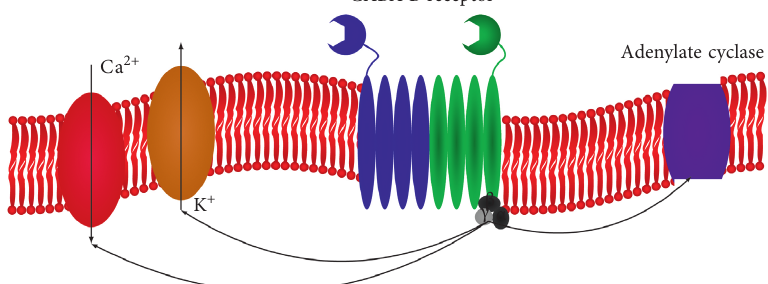
Figure 1: An image of a metabotropic GABA B receptor with its G protein couple (black/gray); adenylate cyclase (purple); potassium channel (beige); and calcium channel (red). This original figure depicts the mechanism by which GABA B receptors influence calcium and potassium channels. Source: